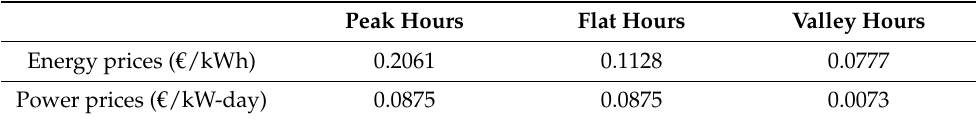
Table 2. Energy and power prices by period of the tariff considered.